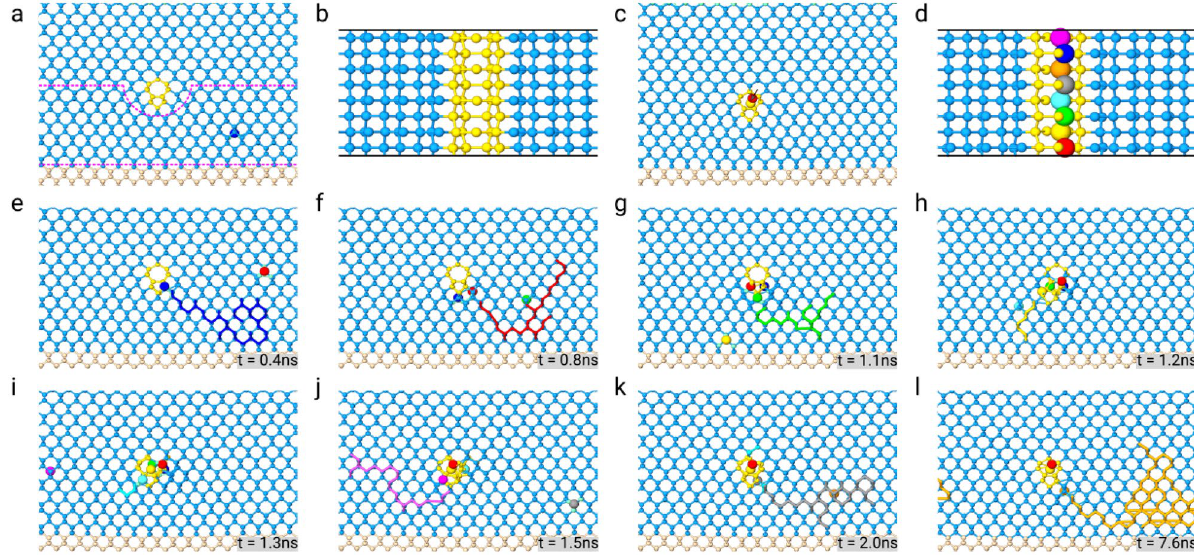
Figure 3. Simulation of edge dislocation climb. Light blue spheres represent Ge atoms, pink spheres Si atoms, yellow spheres highlight the core of an edge dislocation 2.0nm above the interface (Burgers vector � b = a / 2 [¯ 110 ] ). Larger spheres show the position of the vacancies as identified by Wigner–Seitz defect analysis in OVITO. A trajectory is provided for each vacancy by a colored line. ( a ) Starting configuration: a Lomer dislocation 2.0nm above the Si/Ge interface, the “vacancy spawn” region is shown by the dashed purple line. ( b ) top view of the dislocation core. ( c ) final snapshot after eight vacancies has been inserted in the cell (a black arrow shows the displacement of the dislocation), with the corresponding top view ( d ). Simulation snapshots are provided in sequence; the corresponding simulation time is shown in the inset ( e – l